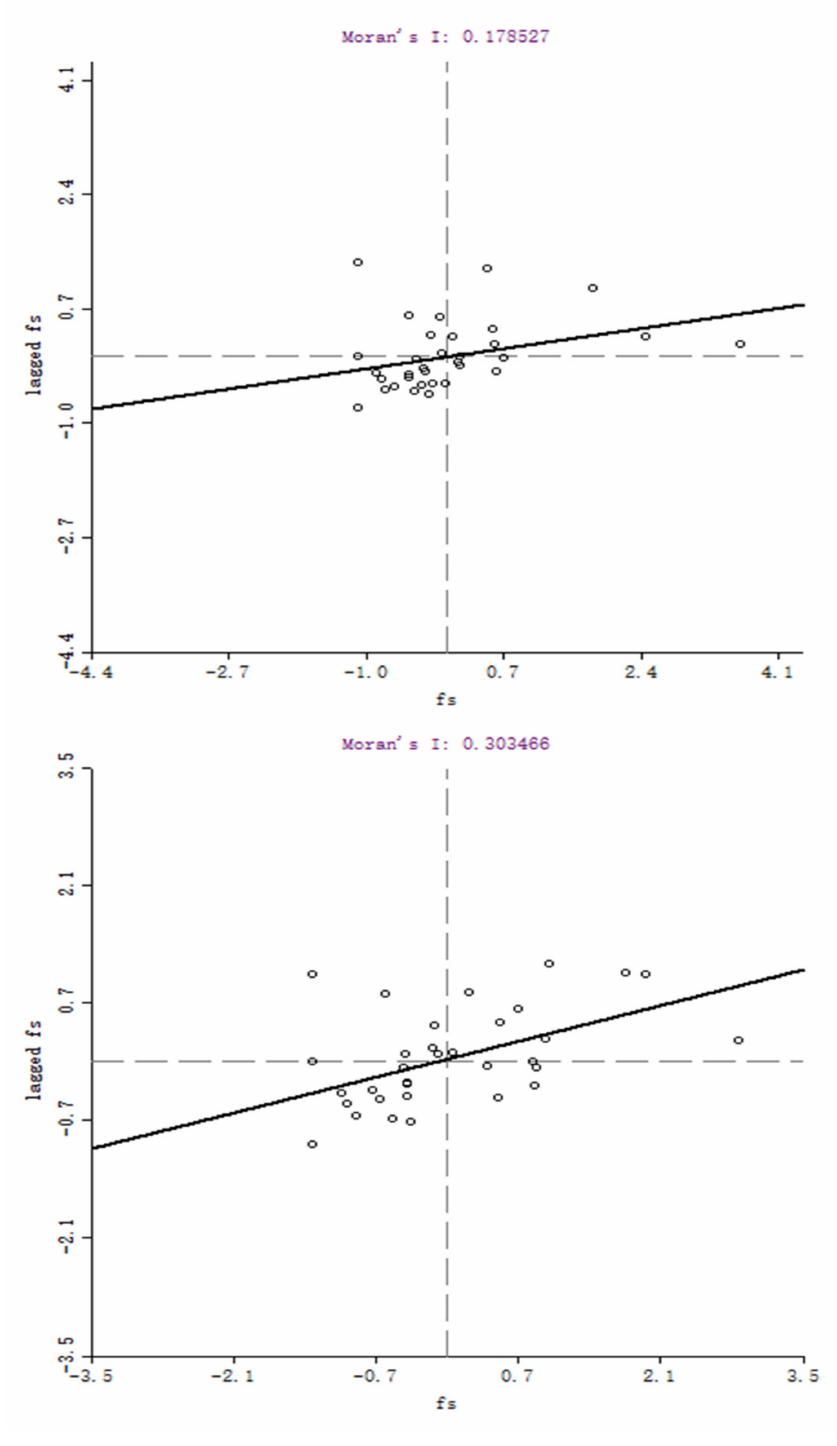
Figure 2. MSP for Chinese provincial FSP based on Ad-weight in 2005 and